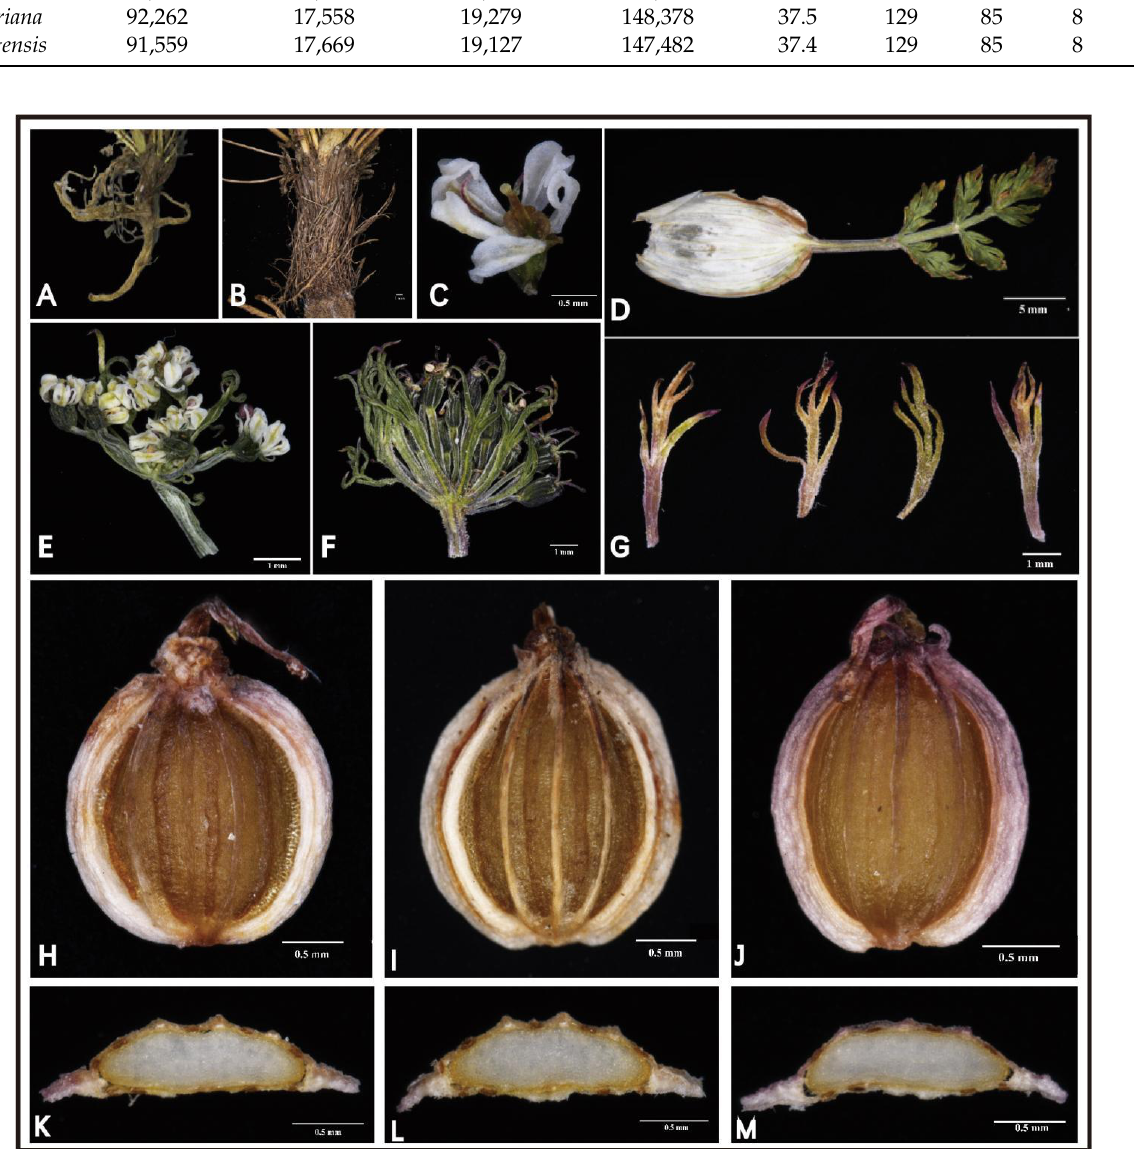
Figure 2. Morphology of Ligusticopsis litangensis ( A ) root; ( B ) stem (base); ( C ) flower; ( D ) leaf; ( E ) inflorescence; ( F ) infructescence; ( G ) bracteoles; ( H – J ) oblong-globose fruit; ( K – M ) mericarp transverse section.